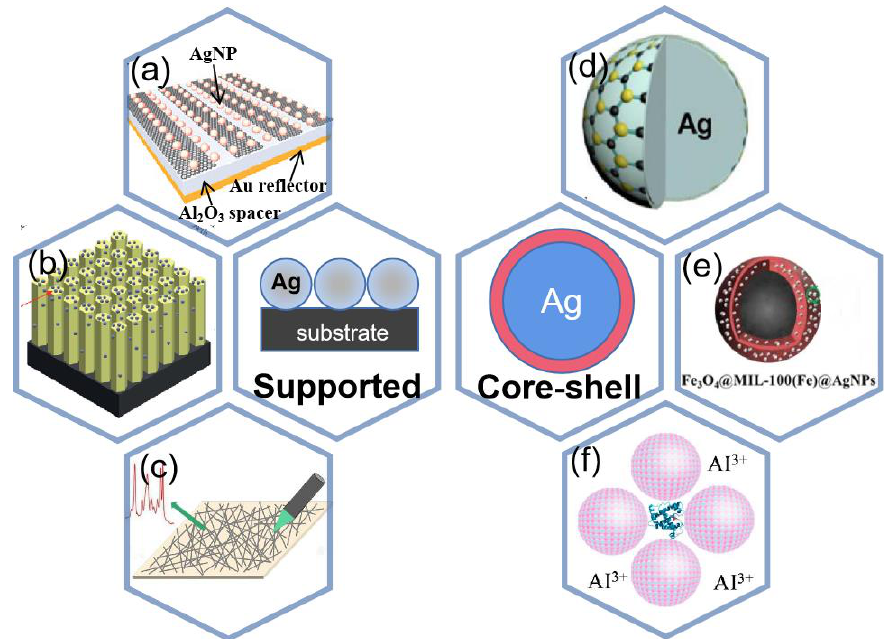
Figure 12. Two different composite modes ( a ) Experimental schematic of the shared substrate. Reprinted with permission from Ref. [138]. Copyright 2021, Small. ( b ) Schematic of the Ag@ZnO chip. Reprinted with permission from Ref. [139]. Copyright 2021, RSC Advances. ( c ) Schematic diagram of silver nanowires array. Reprinted with permission from Ref. [140]. Copyright 2022, Spec- trochimica Acta Part A: Molecular and Biomolecular Spectroscopy. ( d ) Schematic of MoS 2 /AgNPs. Reprinted with permission from Ref. [141]. Copyright 2016, Applied Surface Science. ( e ) schematic of Fe 3 O 4 @MIL-100(Fe)@Ag NPs. Reprinted with permission from Ref. [142]. Copyright 2022, Micro- chemical Journal. ( f ) Schematic Diagram of Experimental Procedure for SERS Detection of Proteins Using Ag IANPs as Substrates. Reprinted with permission from Ref. [143]. Copyright 2020, Analyt- ical chemistry.